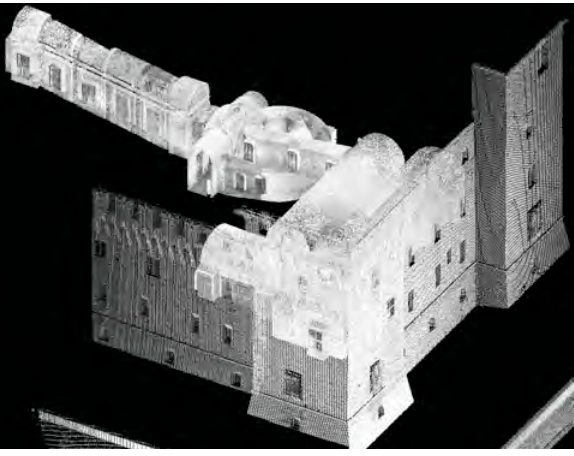
Figure 2. View of the dense point